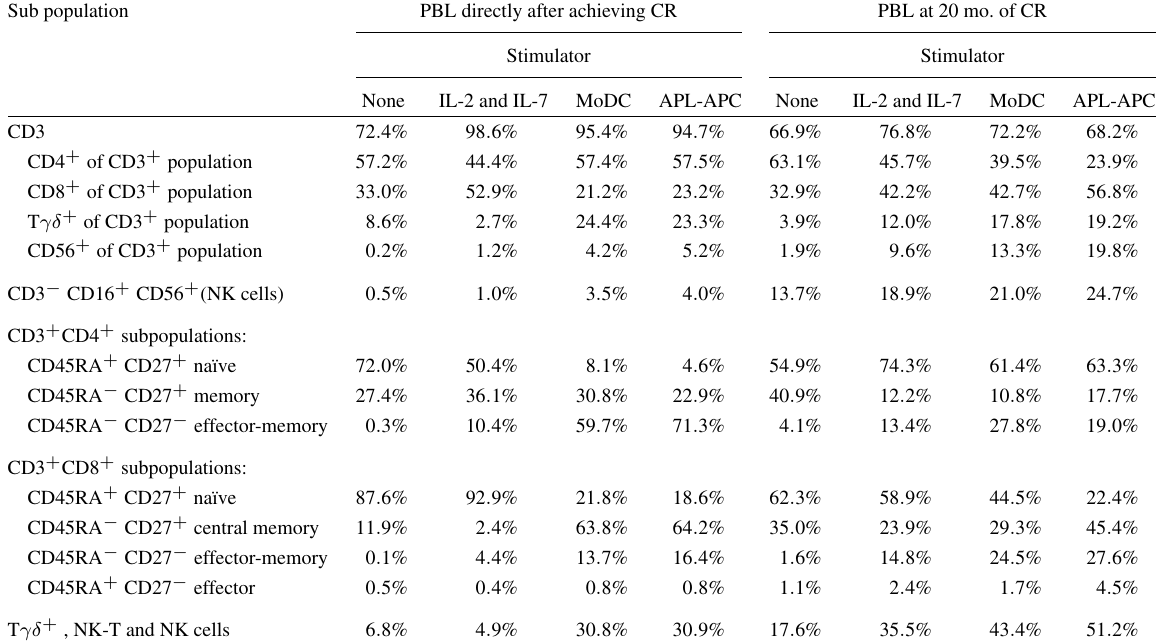
Immunophenotype of autologous remission PBL isolated in complete remission (CR) before and after stimulation by remMoDC or APL-APC, and cytokines